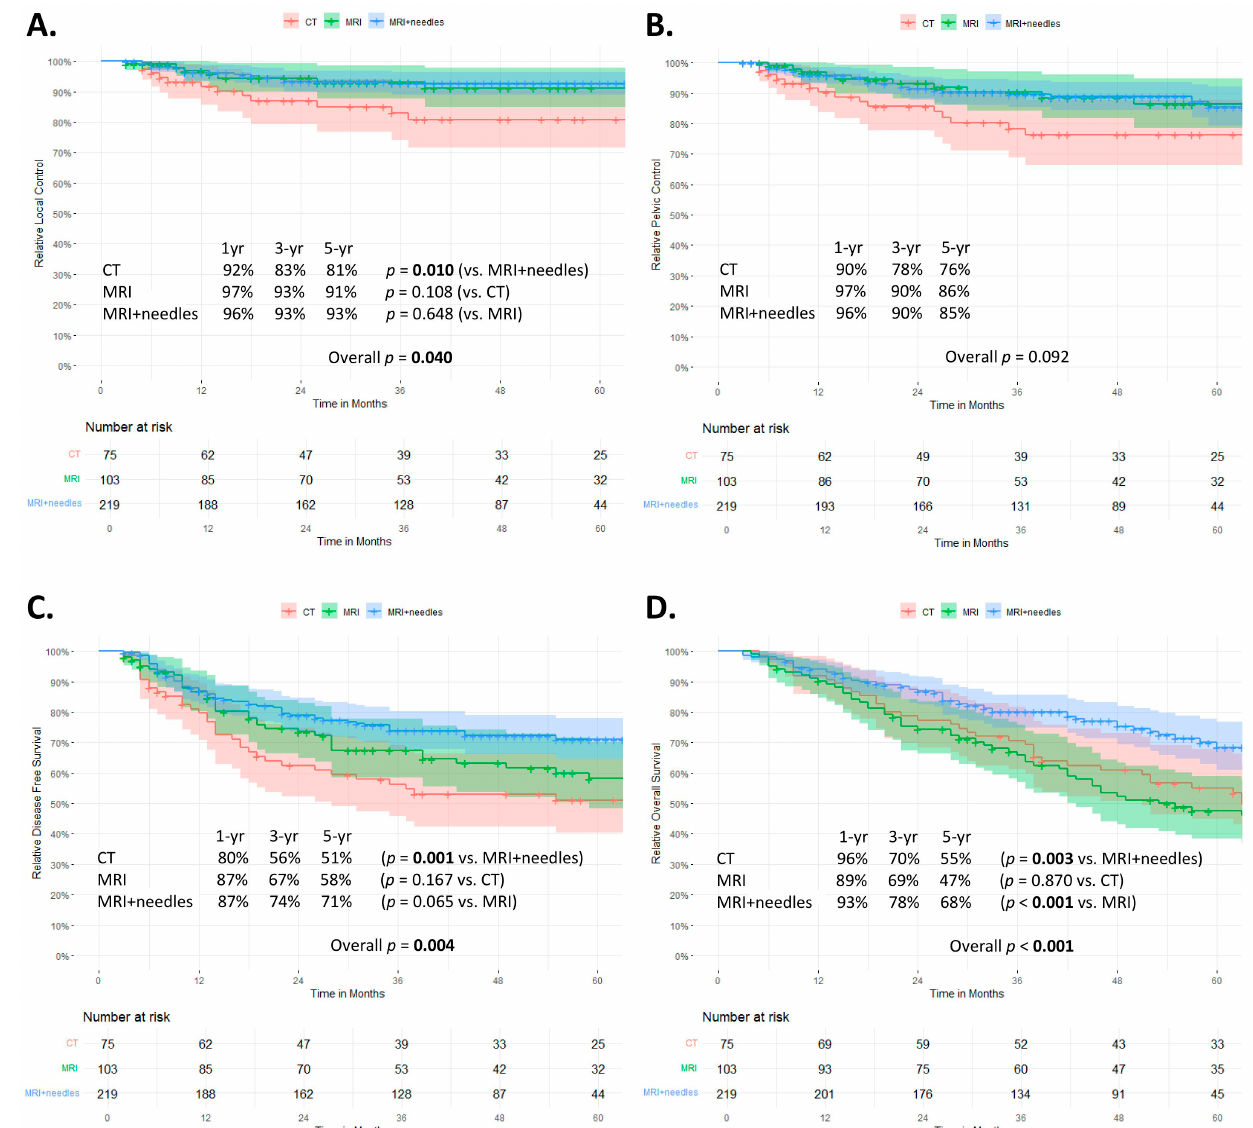
Figure 2. Kaplan-Meier probability estimates stratified by treatment group for ( A ) local control, ( B ) pelvic control, ( C ) disease-free survival, and ( D ) overall survival. The 3-year local control rate for patients with FIGO stage I/II was 86%, 97%, and